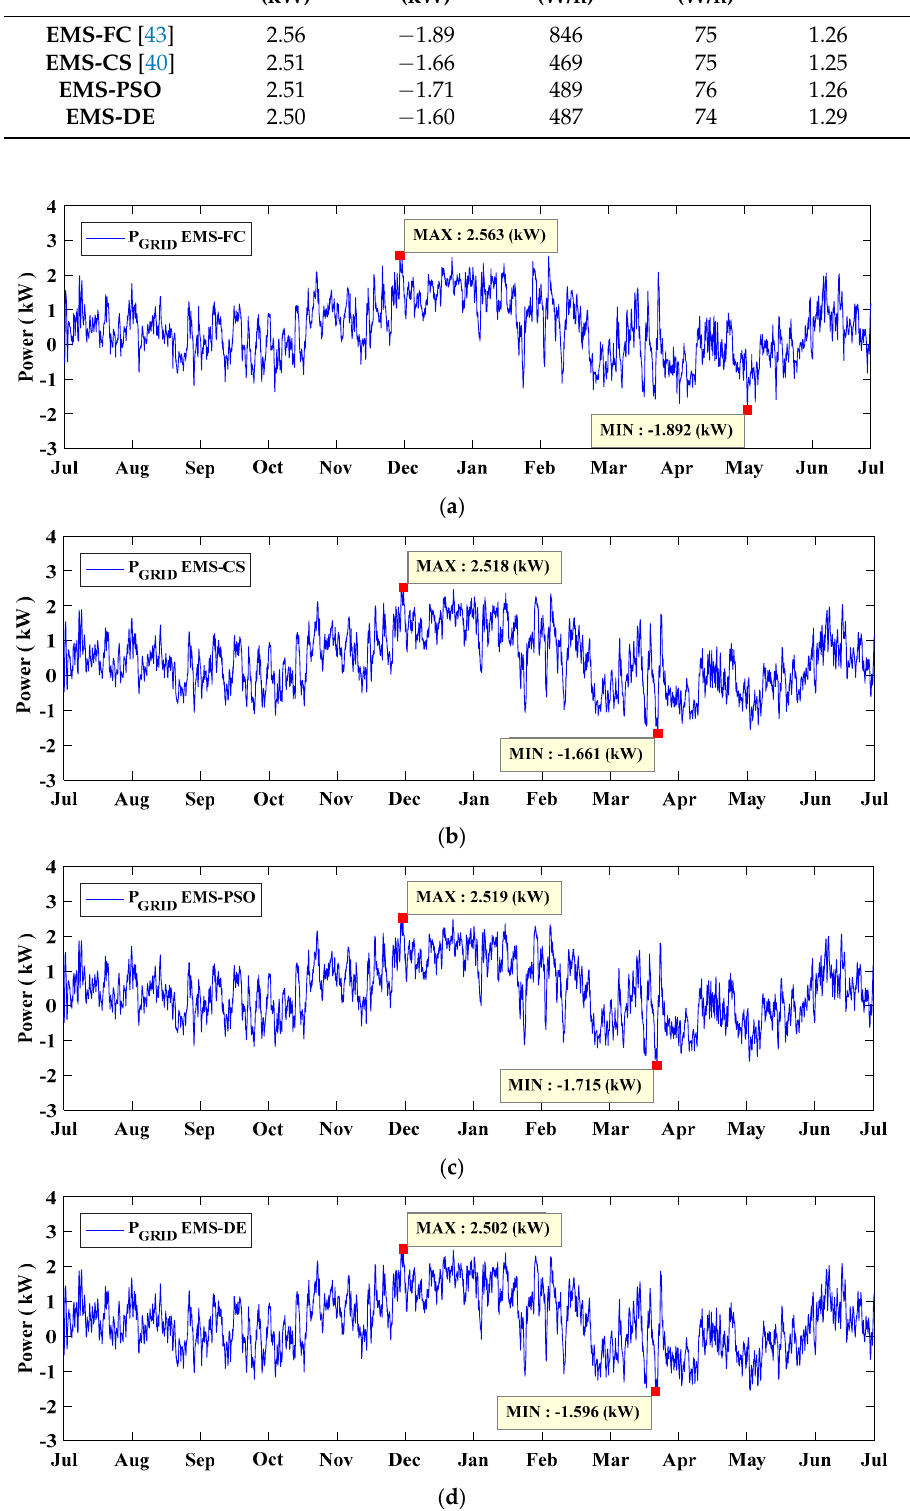
Figure 9. Grid power profile comparison for different EMS designs ( a ) heuristic, ( b ) CS algorithm, ( c ) PSO, and ( d ) DE algorithm.